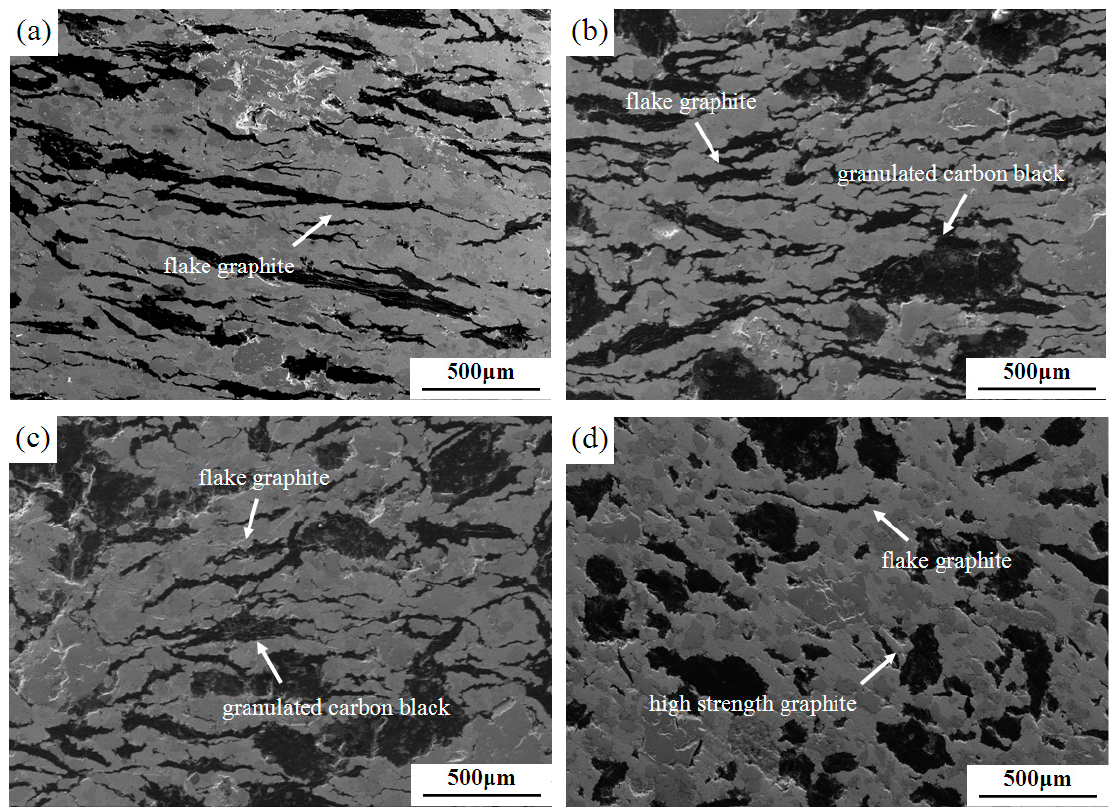
Figure 1. Microstructures with different lubricating phase: ( a ) 0% GCB; ( b ) 5% GCB; ( c ) 10% GCB and ( d ) 5% HSG.